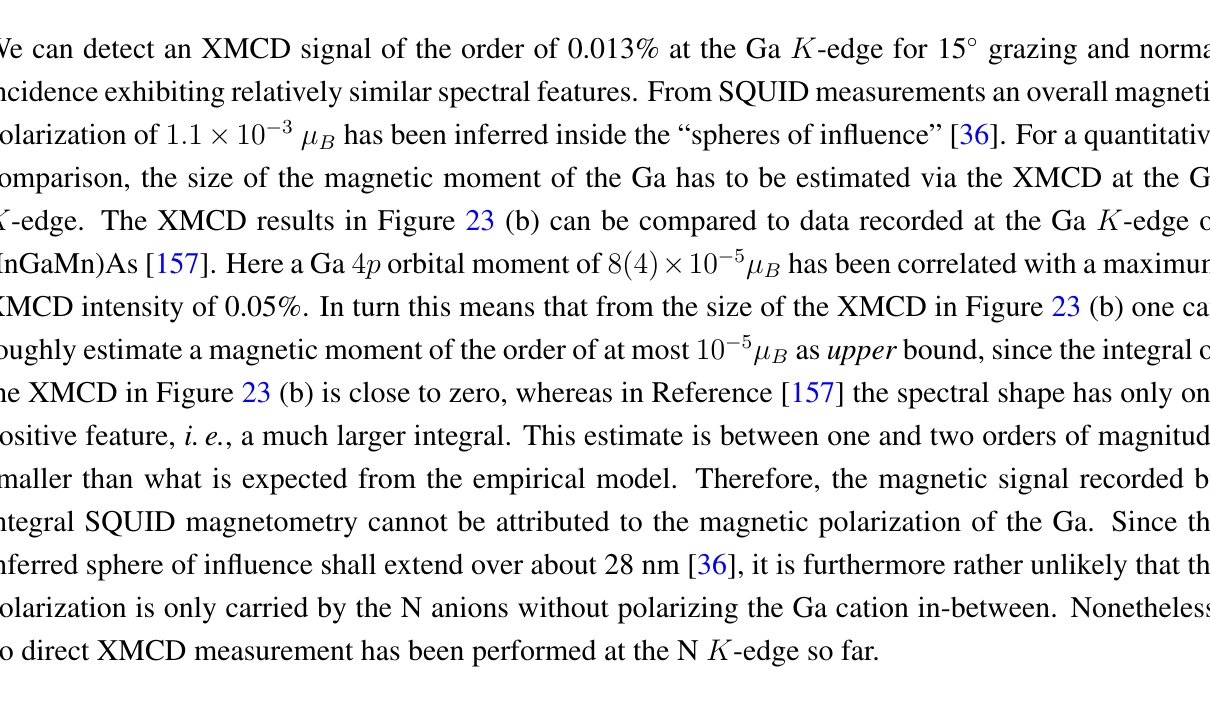
Figure 23. (a) Normalized XANES spectra at the Ga K -edge of the 0.05% Gd:GaN sample recorded at 6 K for 15 ◦ grazing incidence (full black line) and normal incidence (dash-dotted red line) of the X-rays. (b) Respective normalized XMCD signal at 6 T for both